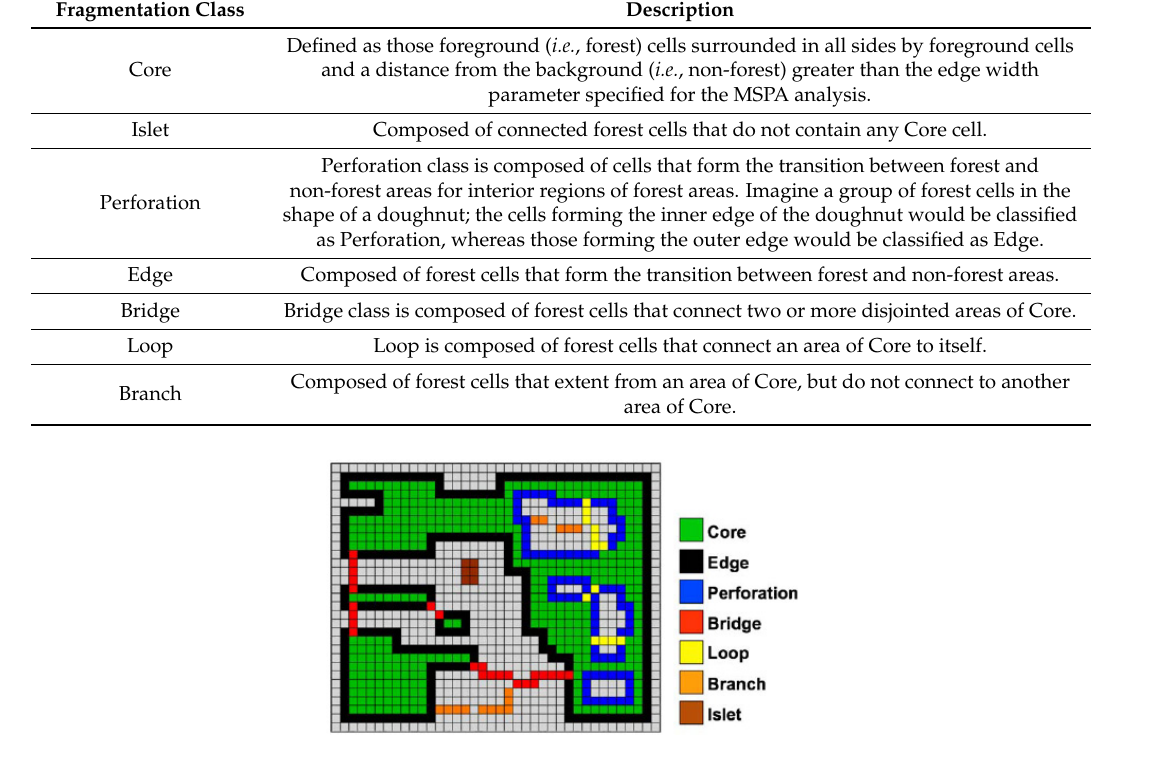
Figure 1. An illustration of the definition of the seven fragmentation classes resulting from the MSPA analysis for a hypothetical area and foreground (forest) patches. Cells in grey color represent the background (non ‐ forest) areas [47]